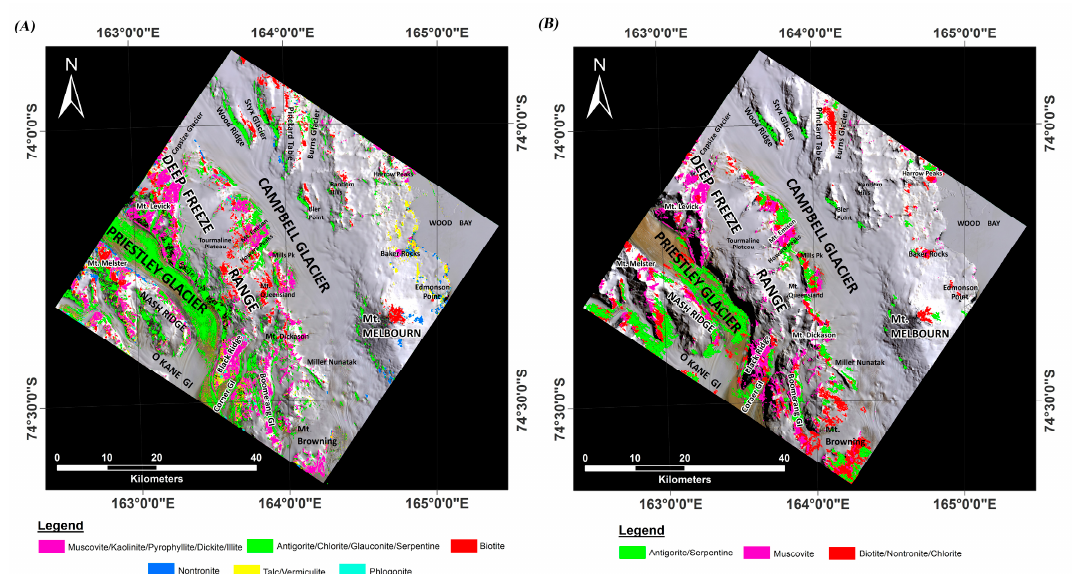
FIG 12 Figure 12. ( A ) CEM classification mineral map for the Campbell Glacier (II) scene derived from fraction images of the selected endmember minerals using ASTER VINR+SWIR bands. ( B ) CEM classification mineral map for the Campbell Glacier (II) scene derived from fraction images of the selected endmember minerals using ASTER TIR